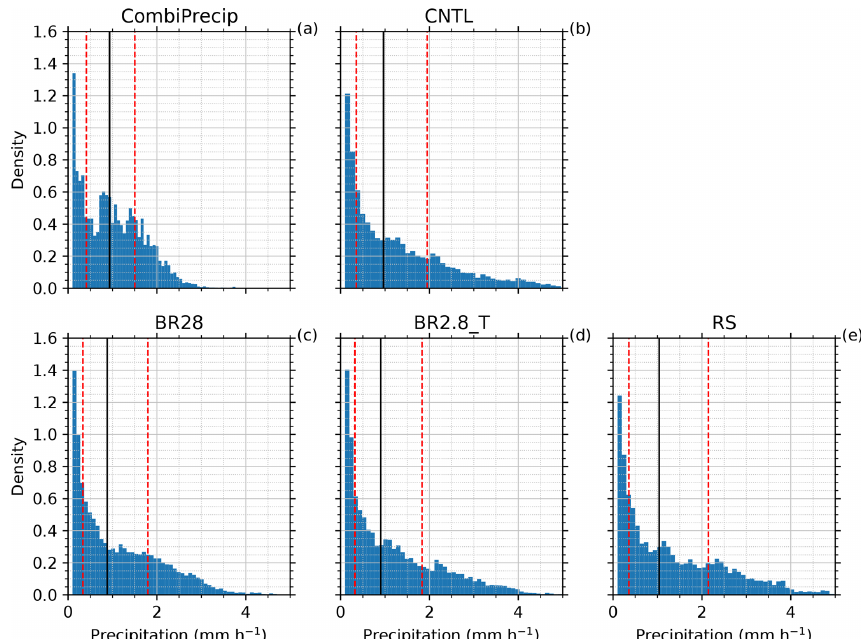
Figure 8. Precipitation rate (mmh − 1 ) histogram for (a) CombiPrecip, (b) CNTL, (c) BR28, (d) BR2.8_T and (e) RS from the domains in Fig. 7. The median (black solid line) and the 25th and 75th percentiles (red dashed line) are